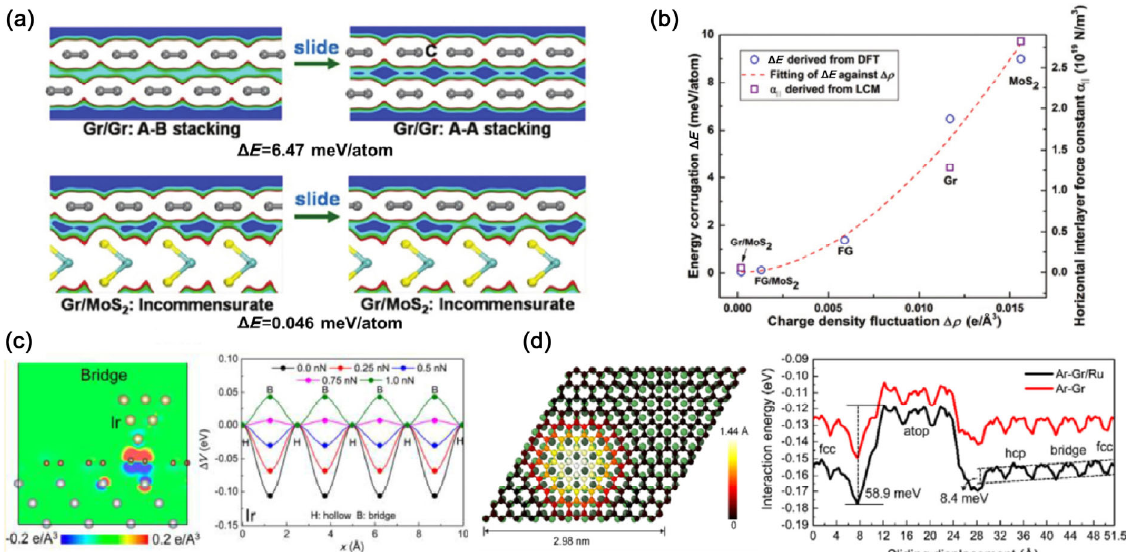
Fig. 33 (a) Mapping the PES corrugation ( Δ E ) and interfacial charge density fluctuation for the Gr/Gr and Gr/MoS 2 systems in sliding. Reproduced with permission from Ref. [29]. © Royal Society Chemistry, 2017. (b) The calculated PES corrugation ( Δ E ) as a function of the interfacial charge density fluctuation (  ), the measured interlayer lateral force constants ( α ║ ) are also plotted for a comparison. Reproduced with permission from Ref. [29]. © Royal Society Chemistry, 2017. (c) Charge transfer distributions and the PES corrugation between a 10-atom Ir tip and graphene/Ni (111) substrate. Reproduced with permission from Ref. [706]. © American Chemical Soeity, 2017. (d) Surface morphology of graphene on Ru (0001) and the corresponding PES corrugations. Reproduced with permission from Ref. [708]. © Institute of Physics,